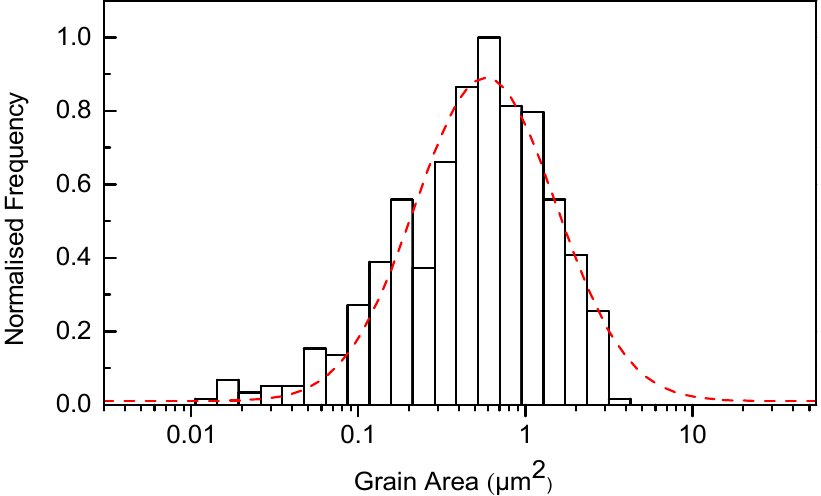
Figure 3. Log histogram of normalised frequency against grain area for Sr05 sintered at 1350 °C for 4 h. Red dashed line shows a log normal fit.